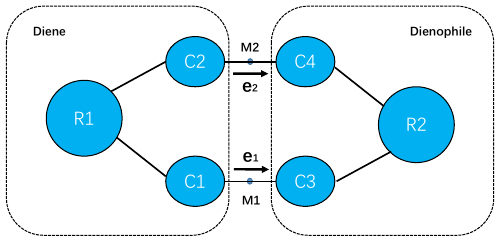
Figure 1. The diagram representation of active sites for Diels–Alder reactions in this work, where C1, C2, C3 and C4 are the four atoms shown in Figure 2, and the remaining atoms in diene are grouped together as R1, and those in dienophile as R2. The unit vector (cid:126) e 1 points from atom C1 to atom C3 and the unit vector (cid:126) e 2 points from atom C2 to atom C4. M1 and M2 are the two middle points of C1–C3 and C2–C4 bonds, on which the solvent electric fields are